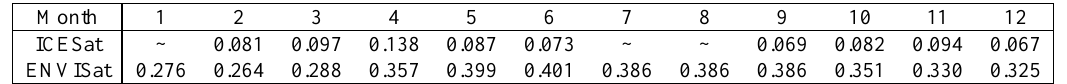
Table 1. Mean standard deviation of the TP LWFs for every